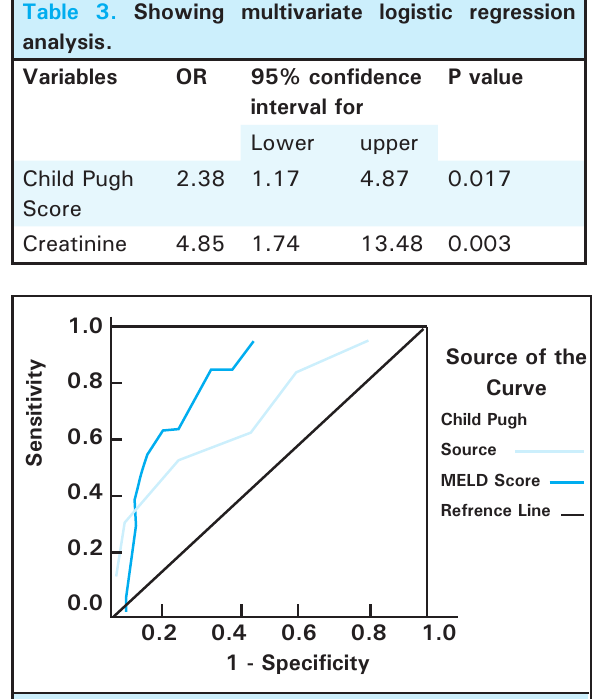
Table 3. Showing multivariate logistic regression